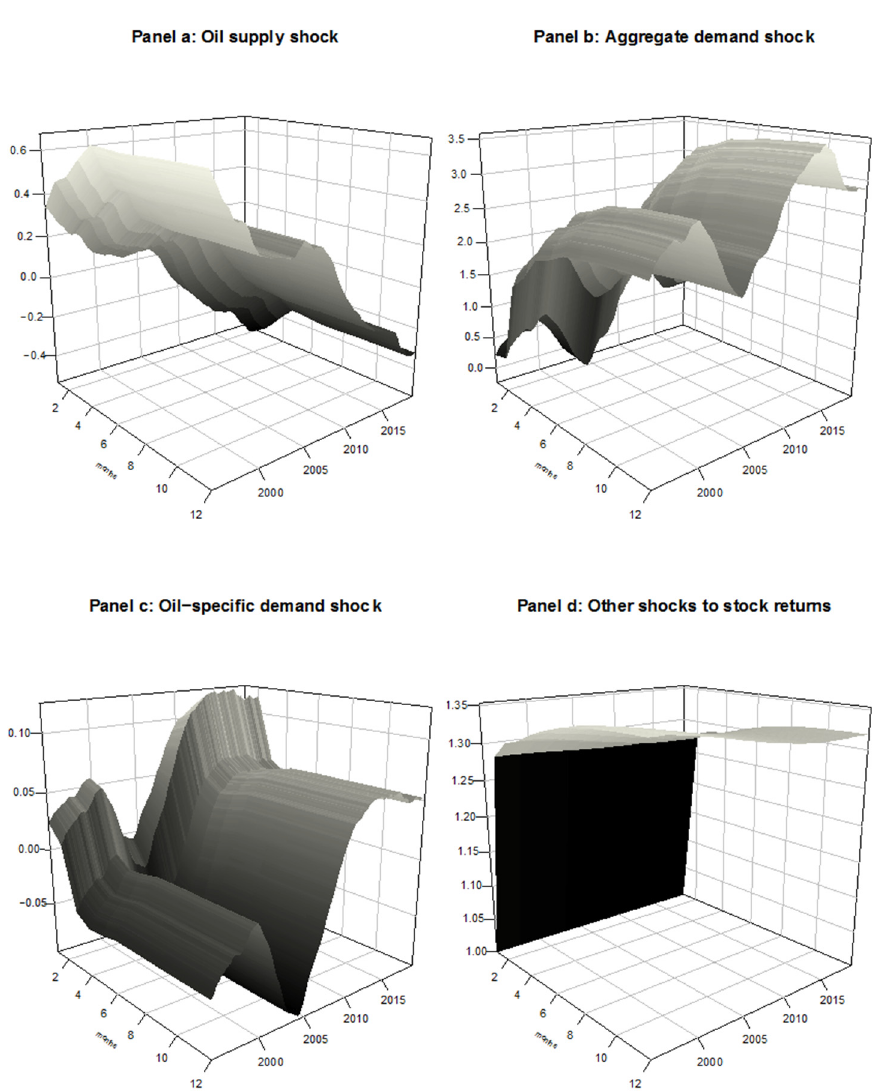
Figure A1. Three-dimensional responses of stock returns to structural shocks. Note: This figure presents the three-dimensional accumulated responses of stock returns to a one-unit shock for each structural shock (1995:04–2019:06).